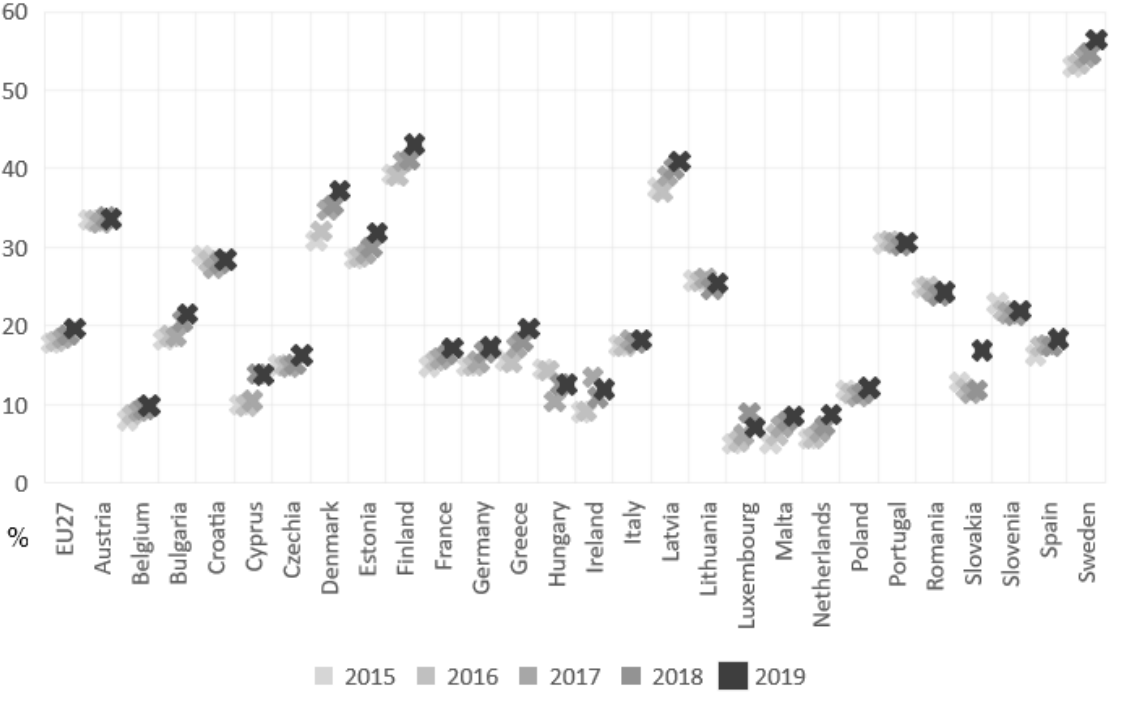
Figure 2. The share of RESs for transport, electricity, heating and cooling in the EU countries from 2015–2019, %. Source: compiled by the authors. 2015–2019, %. Source: compiled by the